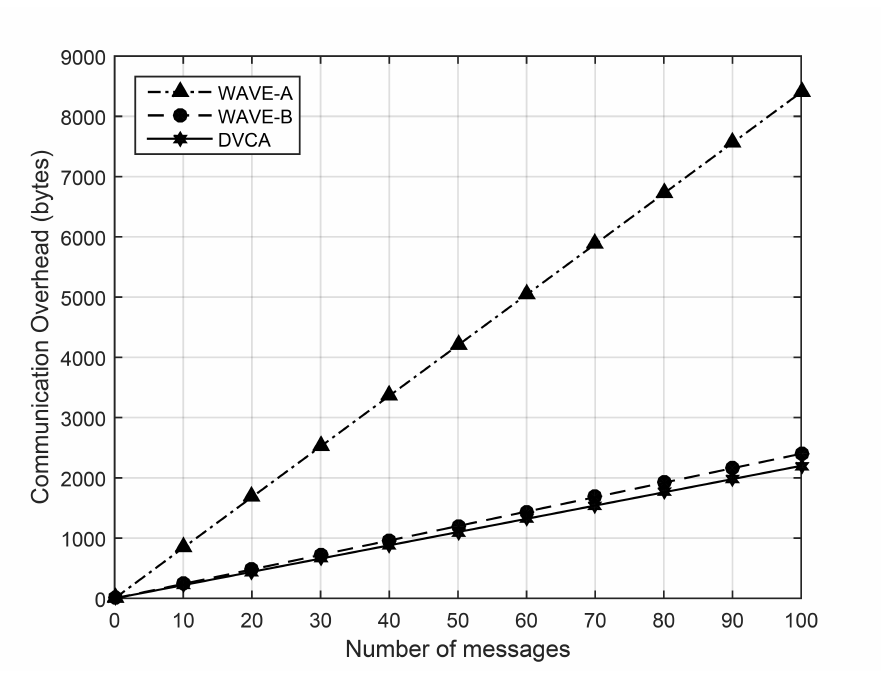
Figure 9. Impact of warning message size on communication overhead.